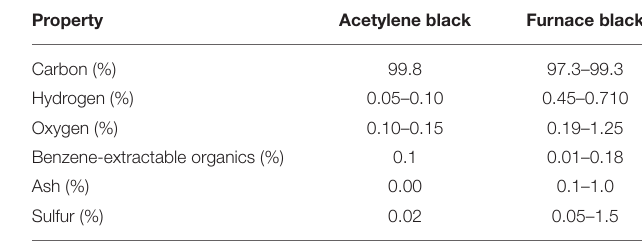
TABLE 4 | Quartz percentages in samples of coal dust: USA: 1985–1992.